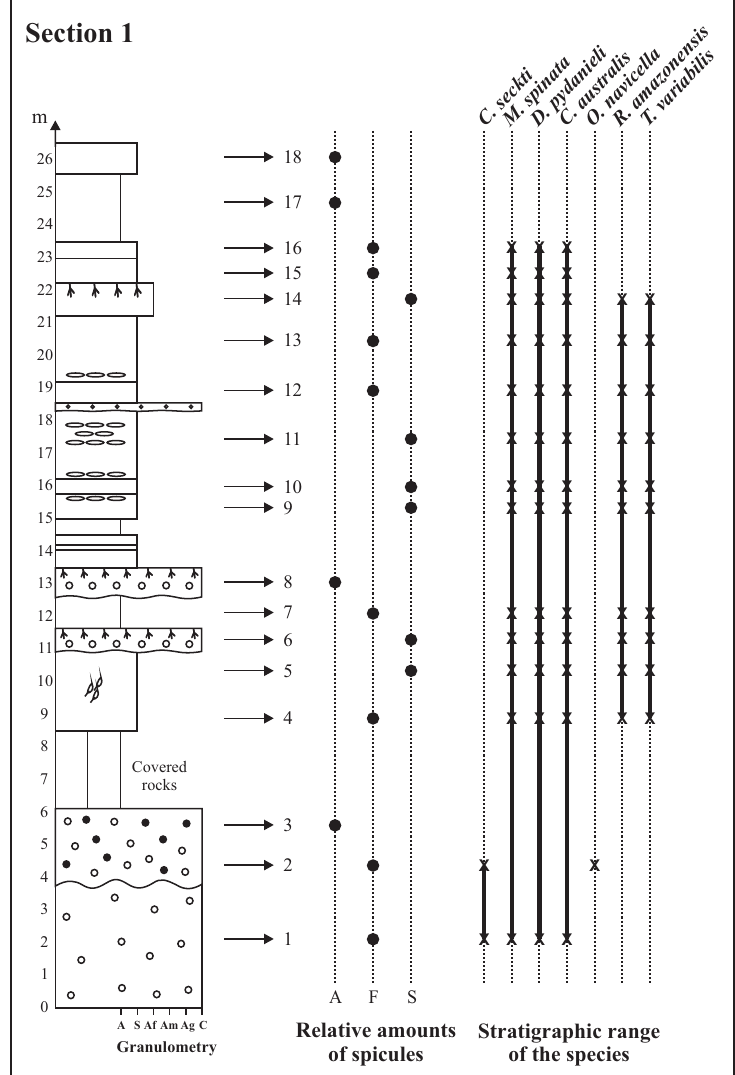
Stratigraphic range of the species Fig. 6. Profile of Section 1 (meters) vis-a-vis the corresponding relative amounts of sponge spicules (A, absent; F. few; S, spongofacies) and stratigraphic range of the identified species. (X, occurrence of a particular species; A, argillite; S, siltstone; Af, fine sandstone; Am, medium sandstone; Ag, coarse sandstone; C, conglomerate). Legend of rocks as Figure 3. From V.S.M., unpublished